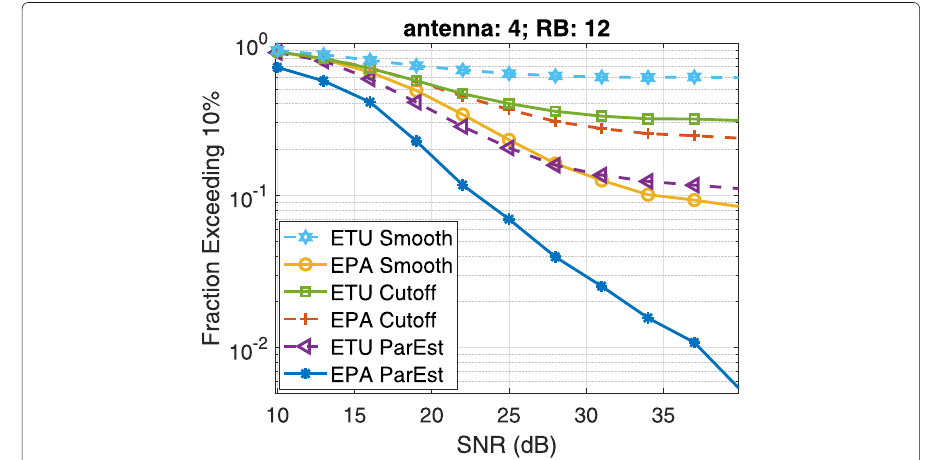
Fig. 8 Fractions of error over 10%. 4